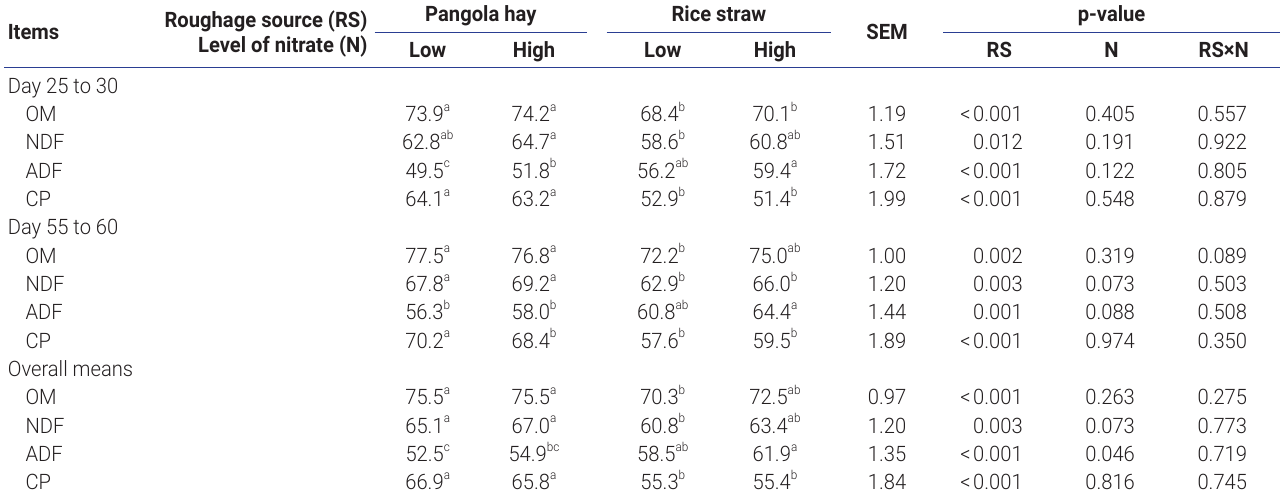
Table 4. Digestibility (% of intake) of organic matter (OM), neutral detergent fibre (NDF), acid detergent fibre (ADF), and crude protein (CP) in goats after the feeding of the experimental rations for 60 days Roughage source (RS) Items Level of nitrate